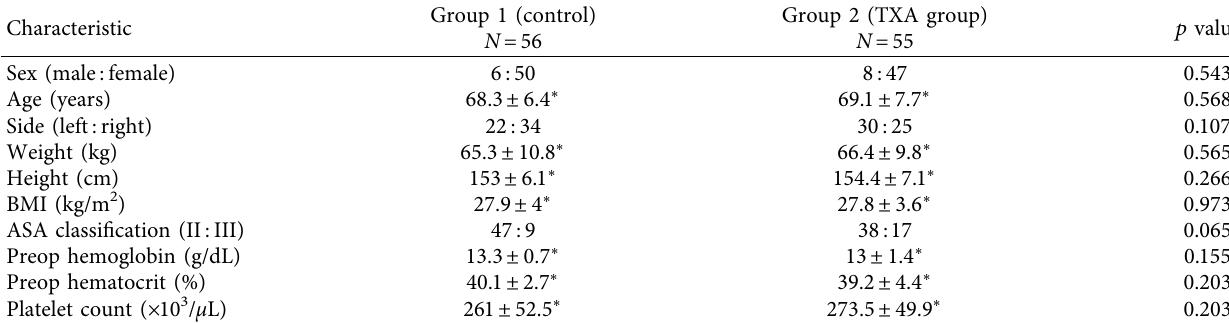
Table 1: Demographic data.